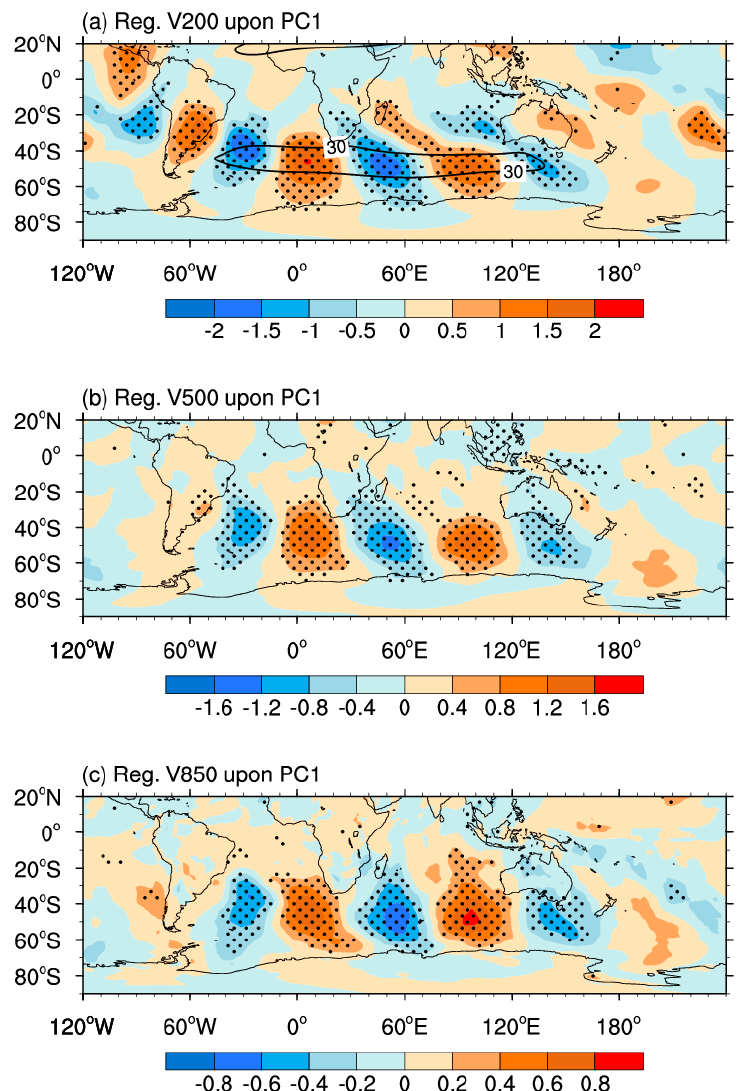
Figure 2. Anomalies of meridional winds (unit: m s − 1 ) at ( a ) 200hPa, ( b ) 500hPa, and ( c ) 850 hPa regressed upon the PC1. Locations with significant anomalies at the 95% confidence level based on Student’s t -test are dotted, and the contour in ( a ) depicts the Southern Hemisphere westerly jet as in Figure 1a. The associated wave train, which is mainly located over the South Atlantic and South Indian Ocean (SAIO), is referred to as the SAIO pattern and the PC1 in Figure 1d as the SAIO index. Related to the SAIO pattern, rainfall varies in the subtropical Southern Hemisphere (Figure 3).